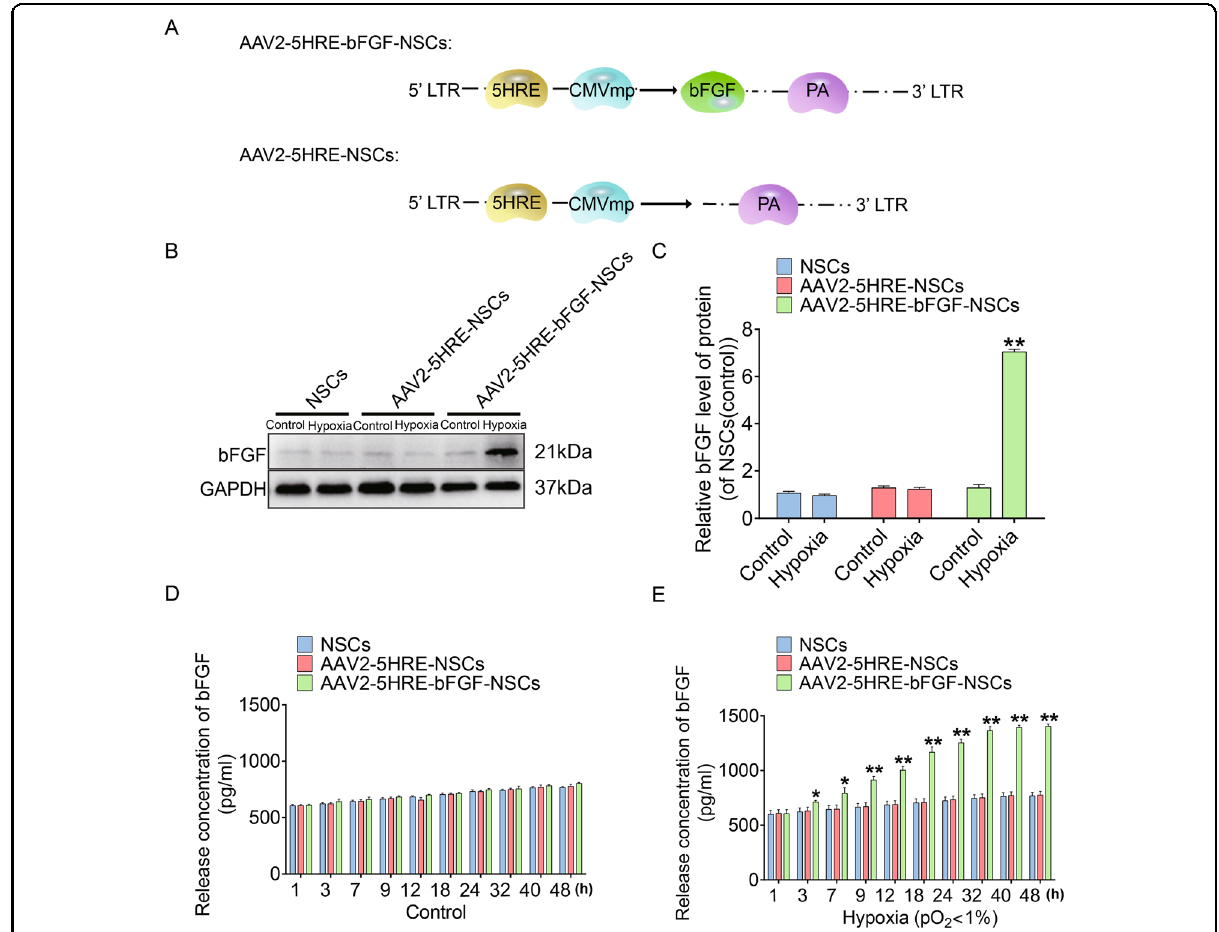
Fig. 1 Preparation and characterization of the AAV2-5HRE-bFGF-NSCs. A Schematic diagram illustrating the construction of expression vectors AAV2-5HRE and AAV2-5HRE-bFGF. B Western blotting analyses of primary NSCs, AAV2-5HRE-NSCs, and AAV2-5HRE-bFGF-NSCs showing the expression of bFGF under normoxic or hypoxic conditions for 24 h. C The quantitative analyses of bFGF protein expression by western blot. D ELISA assay results showing bFGF secretion in primary NSCs, AAV2-5HRE-NSCs, and AAV2-5HRE-bFGF-NSCs under normoxic conditions. E ELISA assay results showing bFGF secretion of primary NSCs, AAV2-5HRE-NSCs, and AAV2-5HRE-bFGF-NSCs under hypoxic conditions. “ * ” and “ ** ” represents P < 0.05 or P < 0.01 versus normoxia control. Data are the mean values ±